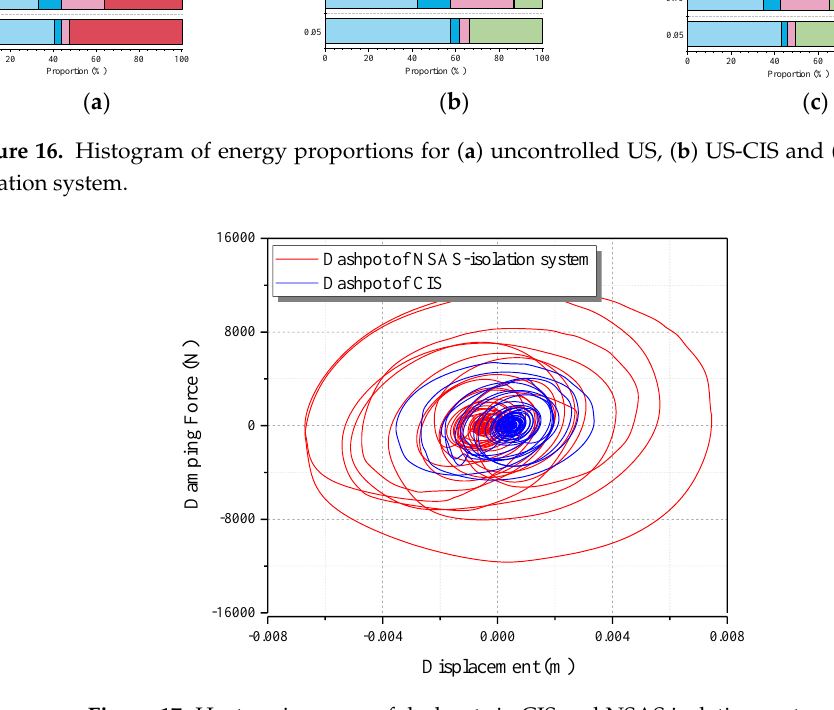
Figure 17. Hysteresis curves of dashpots in CIS and NSAS isolation system.